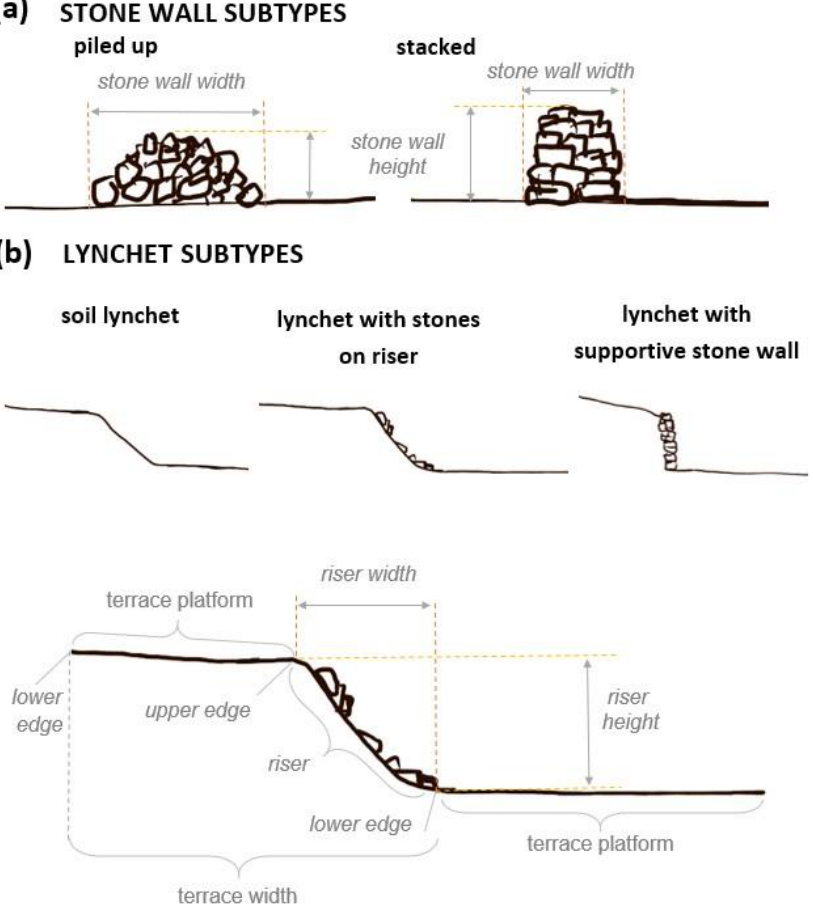
Figure 2. Historical agricultural landforms: ( a )—stone wall subtypes, and ( b )—lynchet subtypes based on internal morphology.